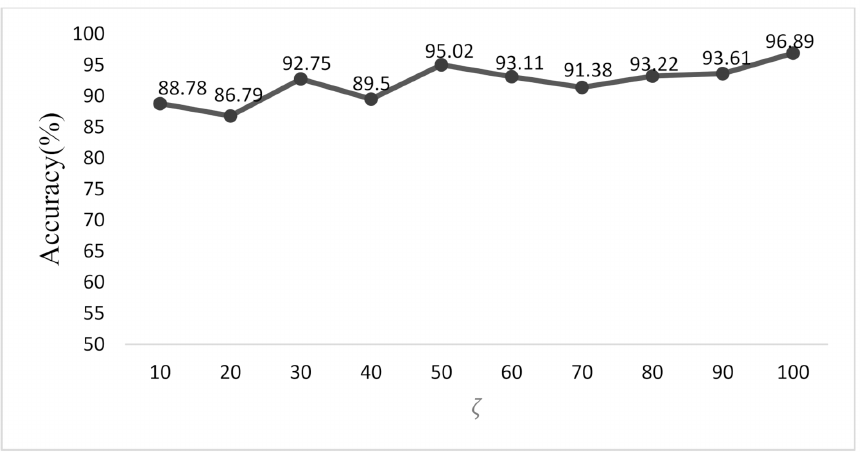
Figure 14. Recognition rates of different weighting coefficients.